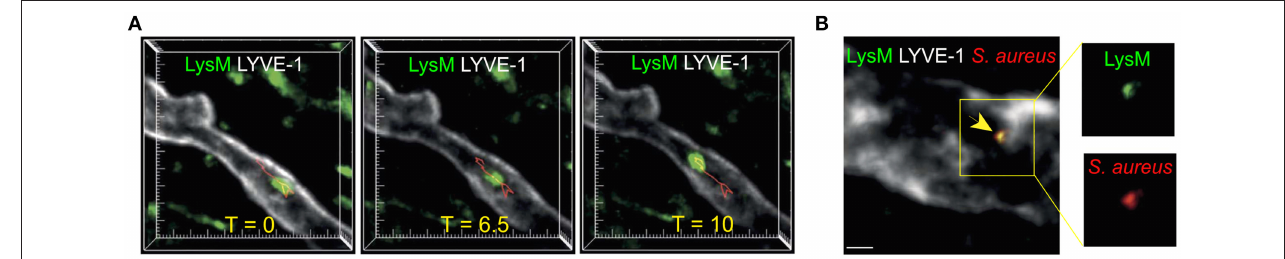
FIGURE 2 | Neutrophil migration in skin lymphatic vessels. (A) Two-photon microscopy was used to examine the lymphatic migration of neutrophils in response to S. aureus. Images are maximum intensity projections of three-dimensional volumes acquired via two-photon microscopy. Lysozyme M + GFP neutrophil (green) migrating inside a lymphatic vessel (LYVE-1, white) is show at three representative time points. Red track indicates neutrophil’s path. Tick marks are 10 µ m apart. (B) Two-photon image of a Lysozyme M reporter mouse skin with a Lysozyme M + (green) neutrophil containing S. aureus (red) inside the LYVE-1 + lymphatic vessel (white). Scale bar is 10 µ m. Figure was adapted from Hampton et al.